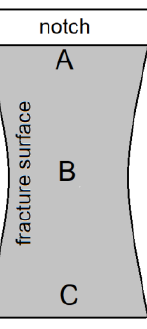
Figure 8. The KCV versus test temperature dependence for Cr-Mn-N steel.